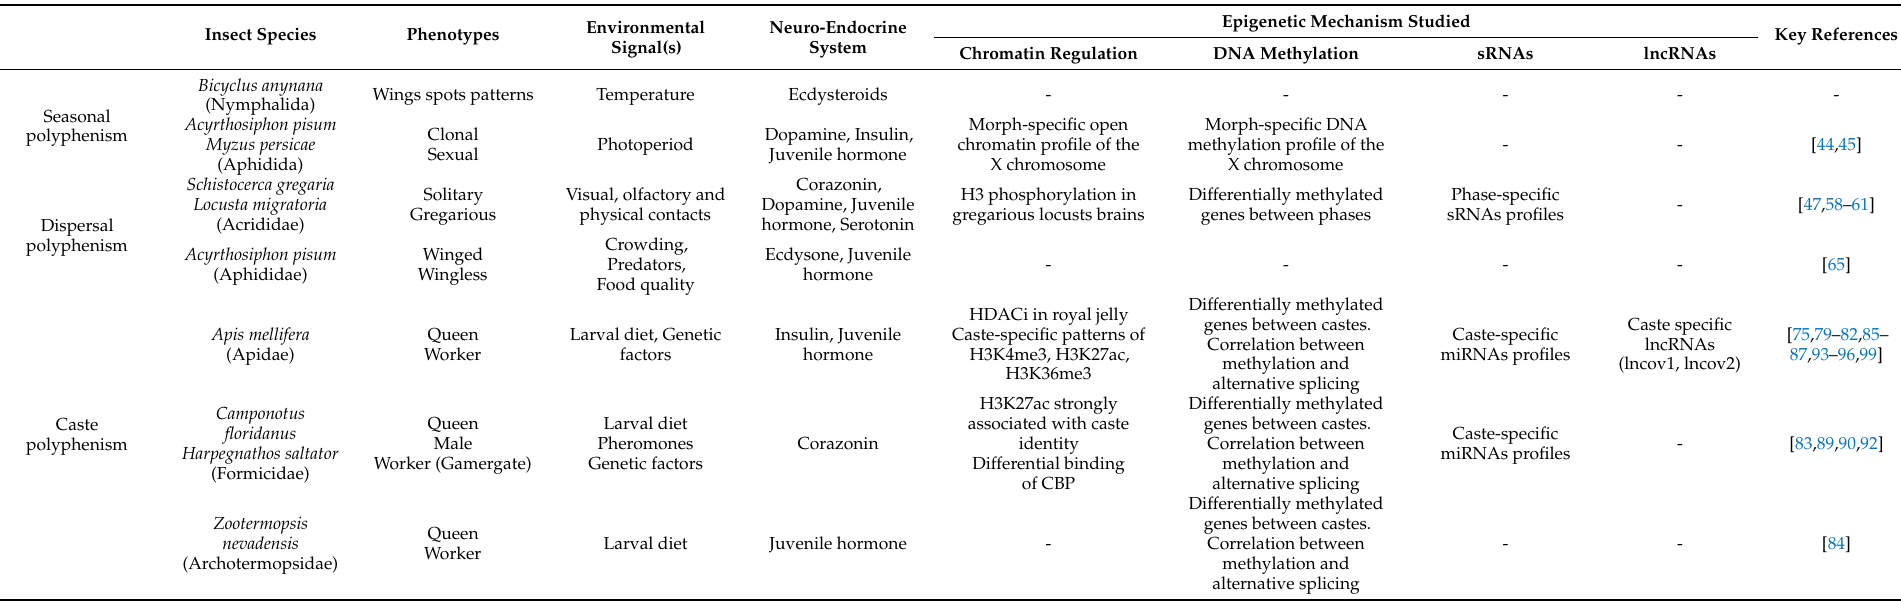
Table 1. Summary of the epigenetic mechanisms involved in the regulation of environmentally-induced polyphenism in